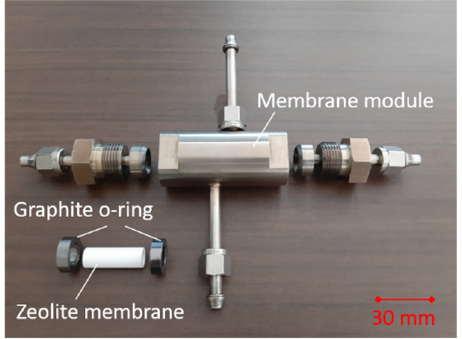
Figure 1. The photo of the membrane module for the vapor permeation test.